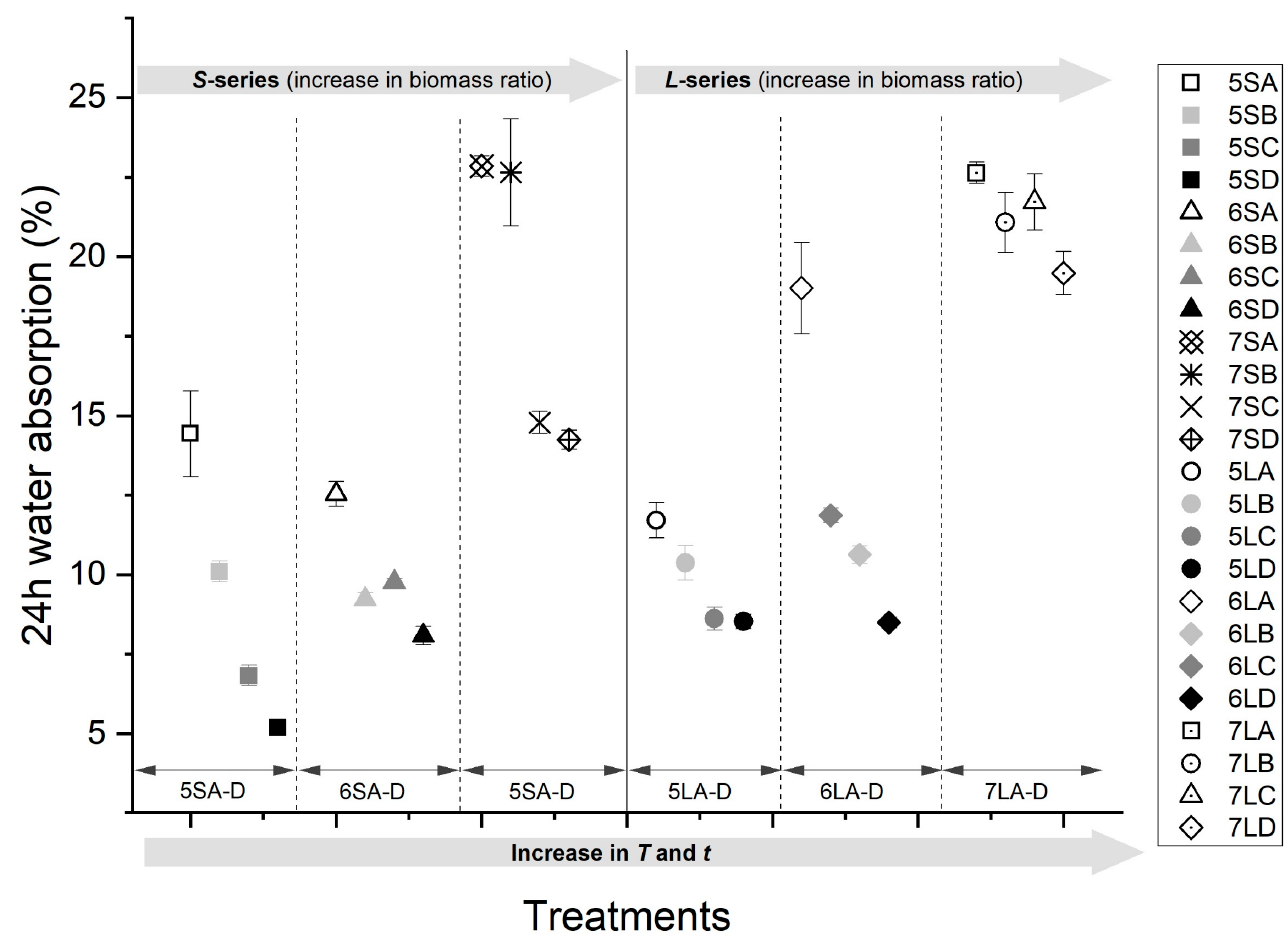
Figure 7. A 24 h WA of WPCs pressed at different temperatures and times (A–D) with 50, 60, and 70% biomass at two particle sizes ( S and L ).